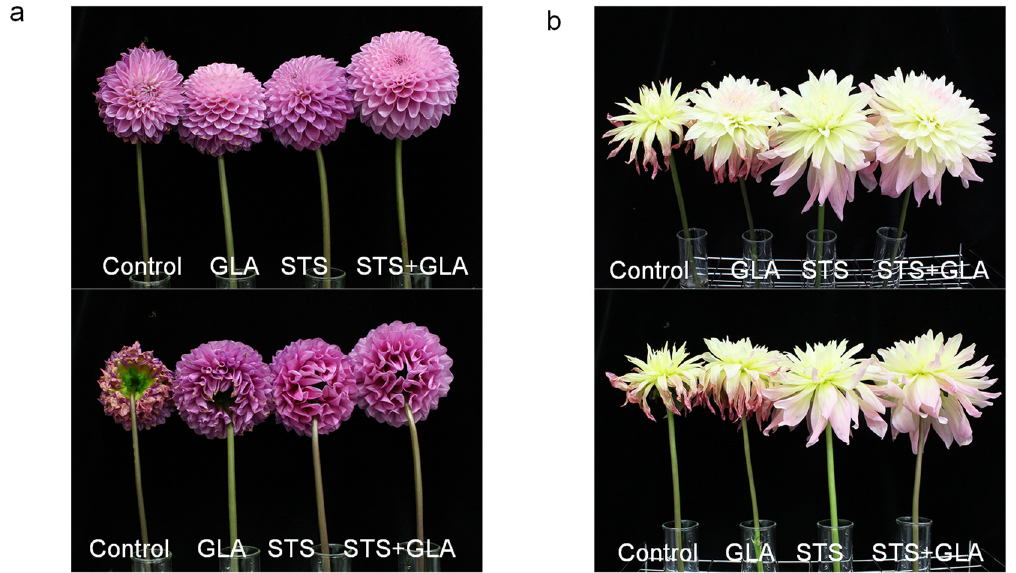
Figure 8. Effect of pulse treatment with STS followed by continuous treatment with GLA on the vase life of cut dahlia. ( a ) ‘Micchan’ on day 7; ( b ) ‘Moon Waltz’ on day 7. The upper and lower panels are focused on the inner and outer petals, respectively, in each cultivar.